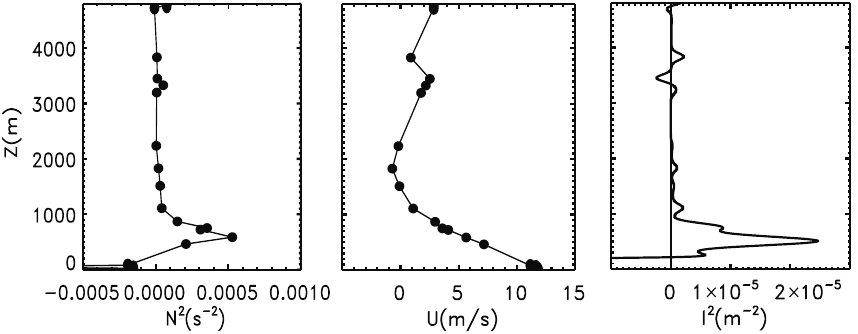
Fig. 2. Atmosphere’s vertical structure and propagation conditions calculated using data from Jeddah weather station (11 May 2004 at 09:00UTC). The buoyancy frequency is shown in (a) ; horizontal wind velocity in the direction of wave propagation in (b) ; and Scorer parameter in (c) . The solid circles in (a) and (b) represent real data whilst the solid curves represent smoothed fits to the data. The l 2 solid curve is calculated values using N 2 and U smoothed